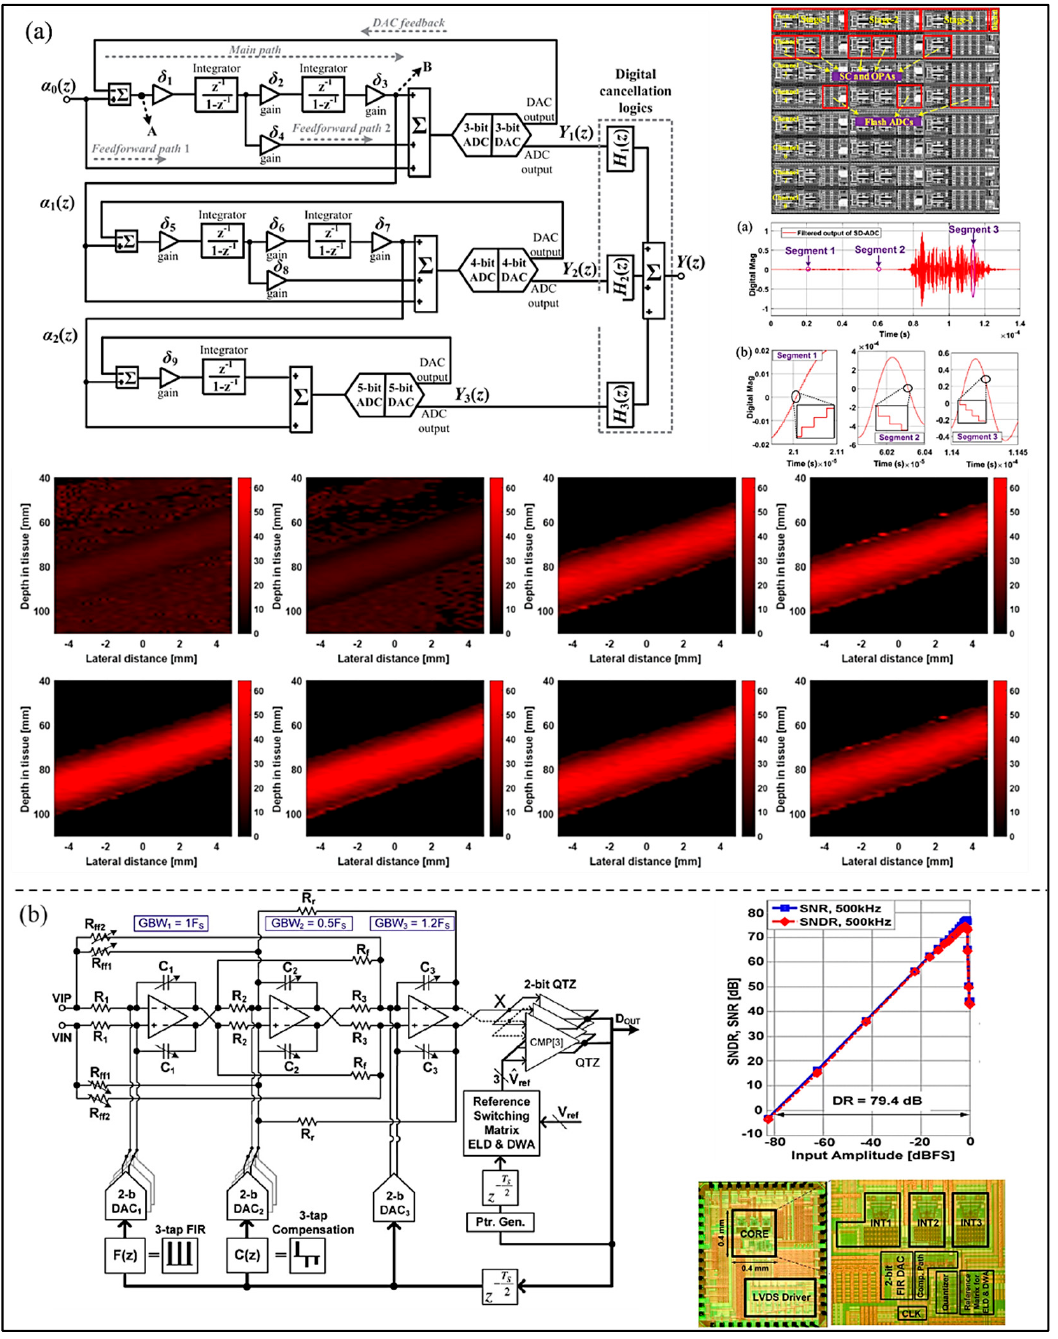
Figure 9. ( a ) Schematic of the proposed MASH Σ - ∆ modulator, die microphotograph, and the simulated performance. (Reprinted from [47], Copyright 2020, with permission from IEEE); ( b ) Schematic of the overall CT Σ - ∆ modulator, measured result, die microphotograph, and 2D ultrasonic doppler images. (Reprinted from [48], Copyright 2015, with permission from IEEE). To supply more sufficient and stable time for the key blocks, Yoon et al. [49] proposed a high-resolution dual-integrating delta–sigma modulator (DI-DSM) adopting dual input paths with slower clocks (as shown in Figure 10a). The feedback DAC of integrator works on conventional fast clocks to eliminate the possibility of noise folding and decrease the area. The results show that the peak values of SNR and SNDR are 81.4 dB and 80.4 dB, respectively, and the power consumption is 24.8 μ W at a 1 V power supply voltage and 10 kHz bandwidth. In order to satisfy the portable requirement of UIS and decrease the power consumption, Muntal et al. [50] proposed a fully differential fourth-order 1-bit CT Σ - ∆ ADC used for a portable ultrasound scanner, as shown in Figure 10b. The power con- sumption measured on the fabricated IC designed in a 65 nm process is 594 μ W, and the